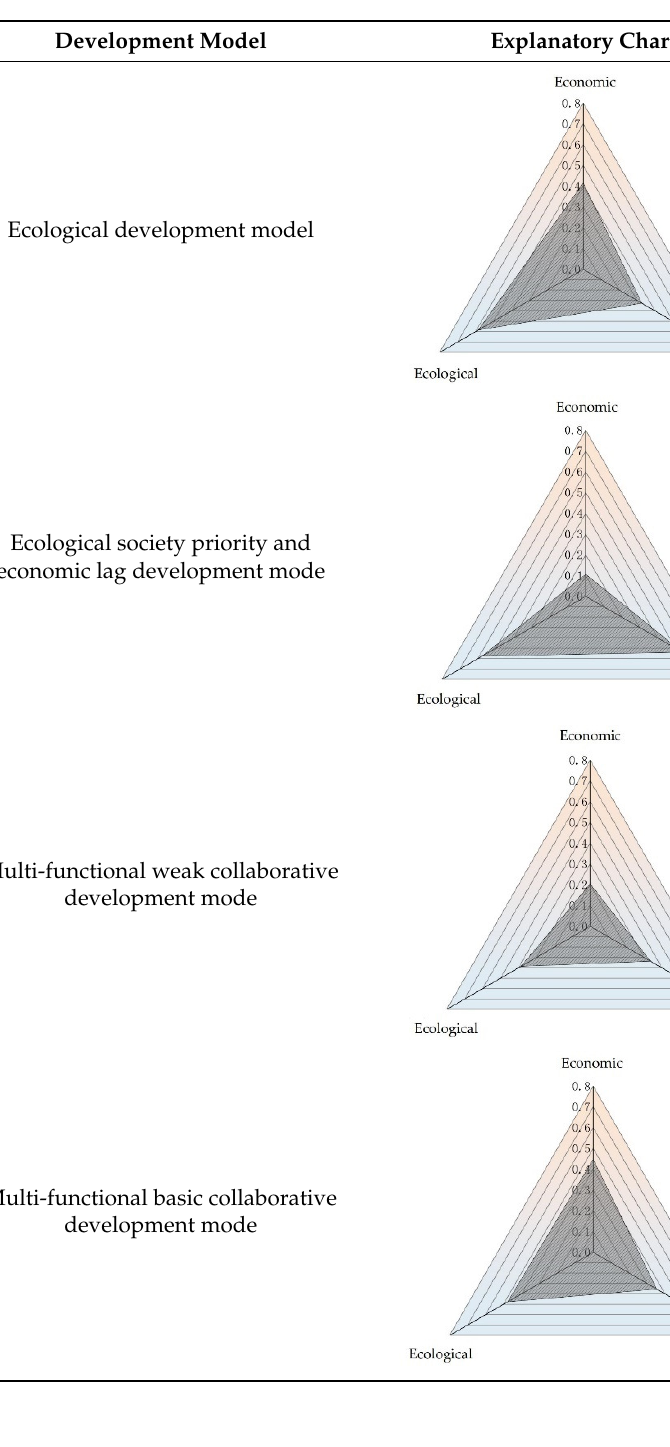
Table 7. Multi-functional development mode of green infrastructure in China.